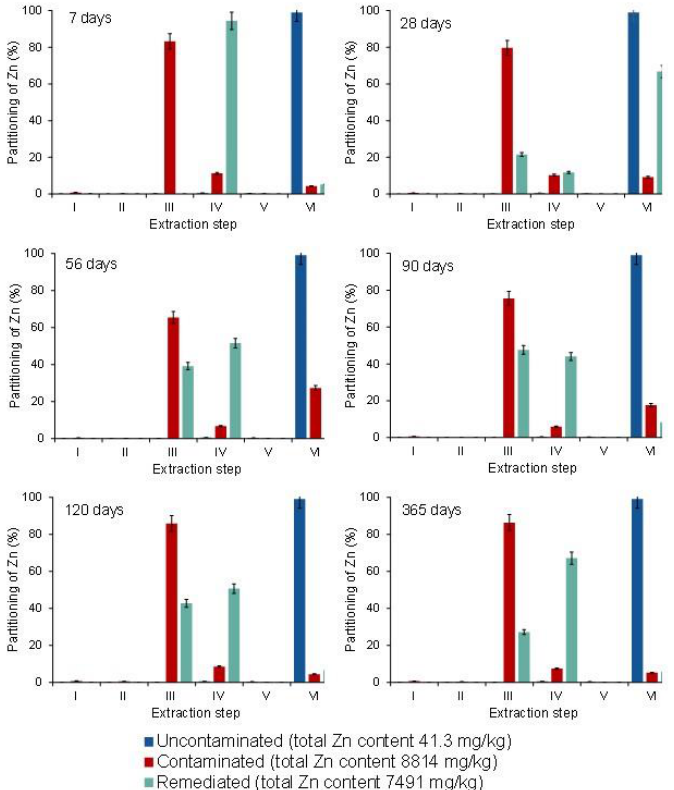
Figure 5. Partitioning of Zn in uncontaminated, contaminated, and remediated soil samples with time elapsed after the remediation. I water-soluble; II exchangeable; III bound to carbonates; IV bound to Fe/Mn oxides and hydroxides; V bound to organic matter; VI bound to silicate lattice. In the uncontaminated soils, Cd, Pb, and Zn were associated almost exclusively with the insoluble residual fraction, bound to the silicate lattice. Their concentrations in the water-soluble and exchangeable fractions, which are mobile in the environment, were negligible, not exceeding 0.0007, 0.0003, and 0.0025 mg/kg for the Cd, Pb, and Zn, re- spectively (see the data from Tables S4–S9). In the contaminated soils, the distribution of Cd, Pb, and Zn changed over time. After the contamination, the Cd was distributed mainly between the carbonate, ex- changeable and residual fractions. In the water-soluble fraction, the Cd concentration exceeded the limiting value for inertness (0.04 mg/kg) [37,38]. During the experiment, the sum of the Cd concentrations in highly the mobile water-soluble and exchangeable frac- tions was around 2–3 mg/kg. The Pb in the contaminated soils was associated with car- bonate, Fe/Mn oxides and hydroxides, and the residual fractions. After the soil contam- ination, the Pb concentration in the water-soluble fraction was close to the limit value for inert materials (0.5 mg/kg) [37,38], while its exchangeable concentrations were up to 30 times higher than in the water-soluble fraction (see data from Tables S4–S9). The Zn in